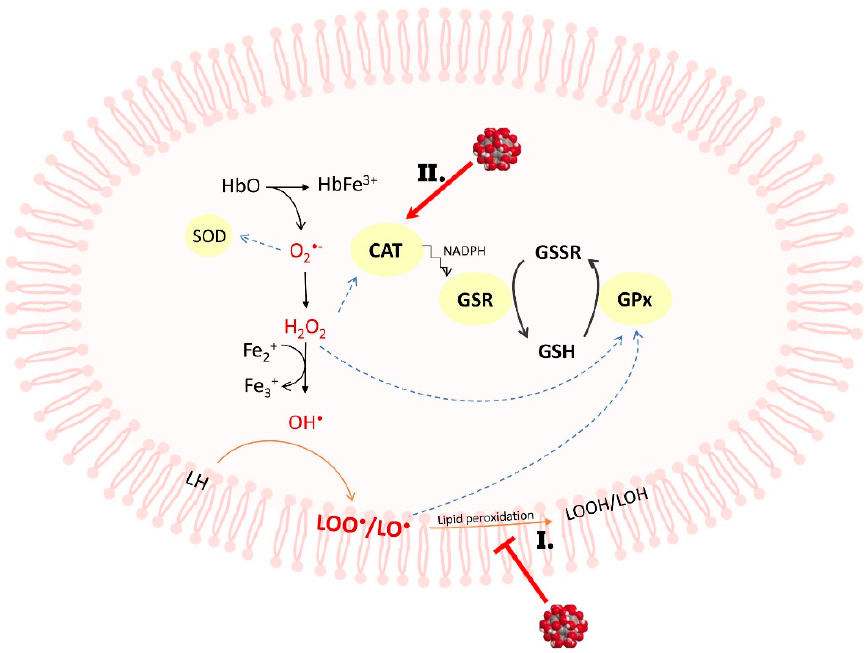
Figure 3. ( I ) Direct interaction with the membrane and radical scavenging of radicals by C 60 (OH) 36 [17,24,35] and ( II ) increasing the activity of antioxidant enzymes such as GSR activity, resulting in an increase in the total pool of GSH, which is a cofactor of GPx, which reduced the formation of lipid peroxides. Therefore, the reduction in hemolysis observed in our previous work could be the result of both processes [35].